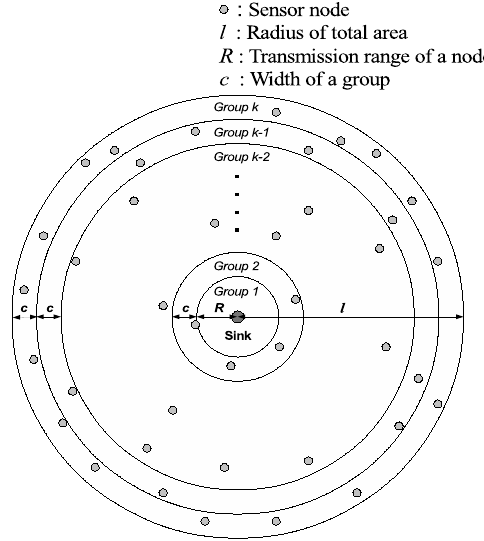
Figure 1. Node deployment in a